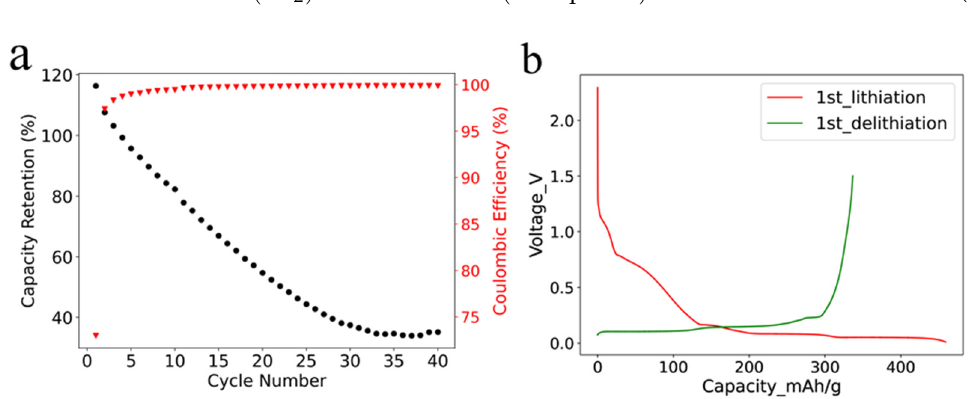
Figure 3. ( a ) Cycling performance of SF graphite with a current of 0.1 C at room temperature; ( b ) voltage-capacity curves for the first lithiation and delithiation processes.